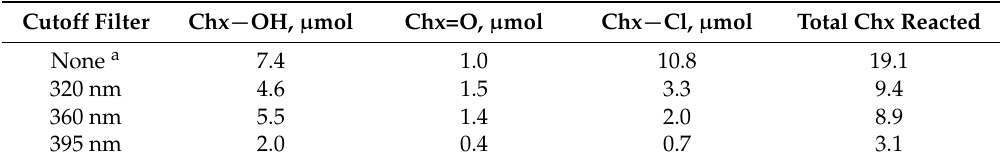
Table 4. Product yields following a 30-min irradiation (100 W Hg lamp) of 1 mL of cyclohexane (0.5% acetic acid), with 25 mL of Et 4 N[FeCl 4 ] and a balloon with 50% O 2 /50% air. Portions of the UV cut off as noted.